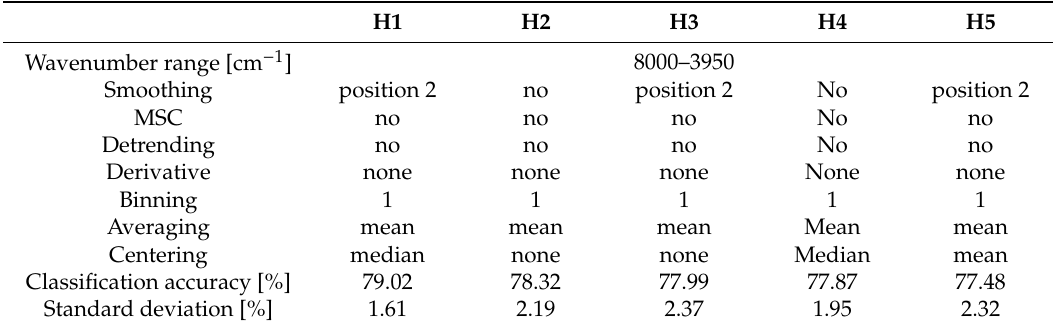
Table 4. Pre-processingstrategieswiththehighestclassificationaccuraciesofall50,545combinations—part1. The selection is based on LDA in a 5-fold repetition of the nested cv. The shown classification accuracies are based on all 212 walnut samples and a 20-fold repetition of the cv.